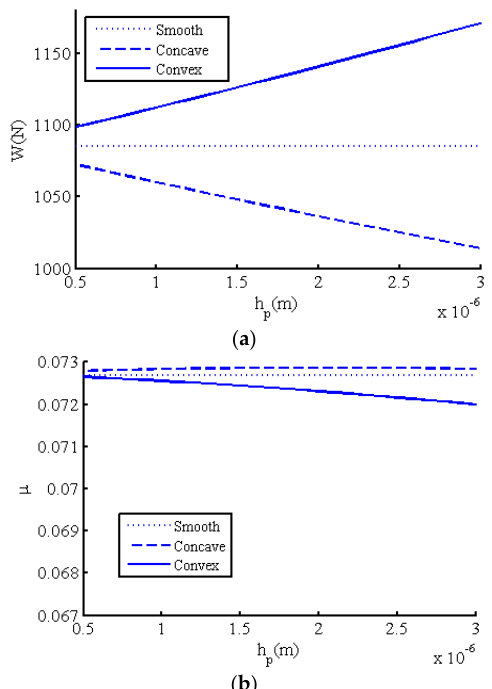
Figure 4. Effect of the texture depth on ( a ) the load capacity and ( b ) the friction